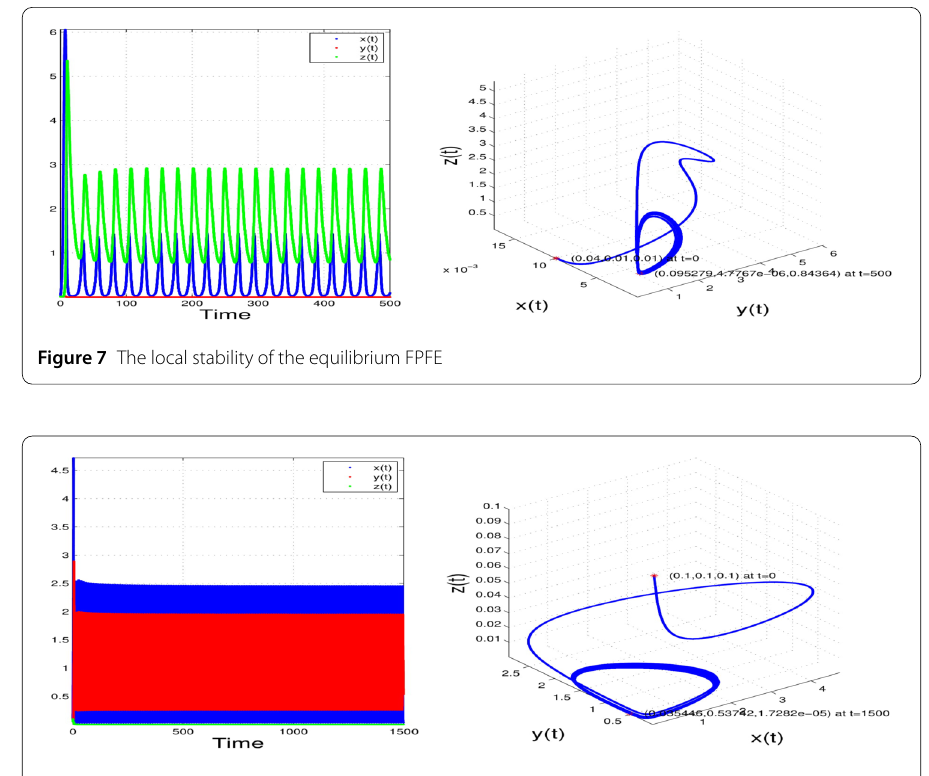
Figure 8 The existence of oscillation generated by the instability of SPFE